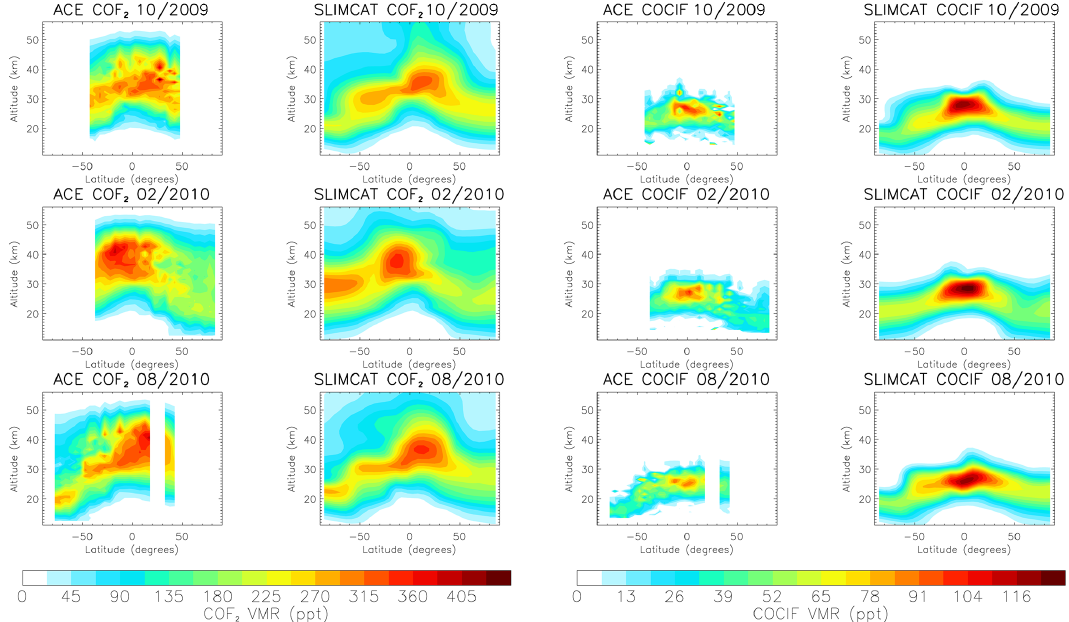
Figure 3. A comparison of COF 2 and COClF zonal means from ACE-FTS and SLIMCAT for October 2009 and February and August 2010.